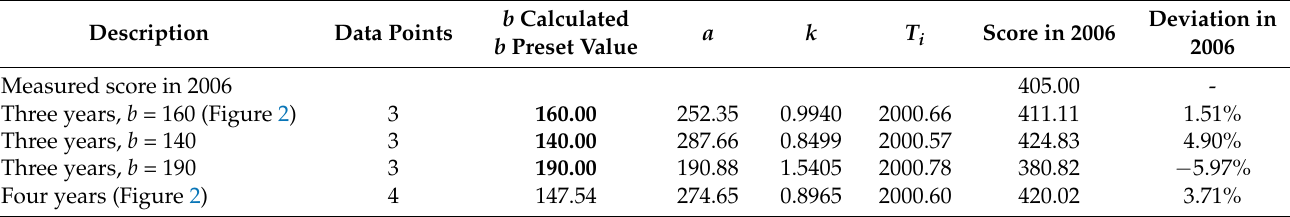
Table 1. Parameters of Gompertz functions and score